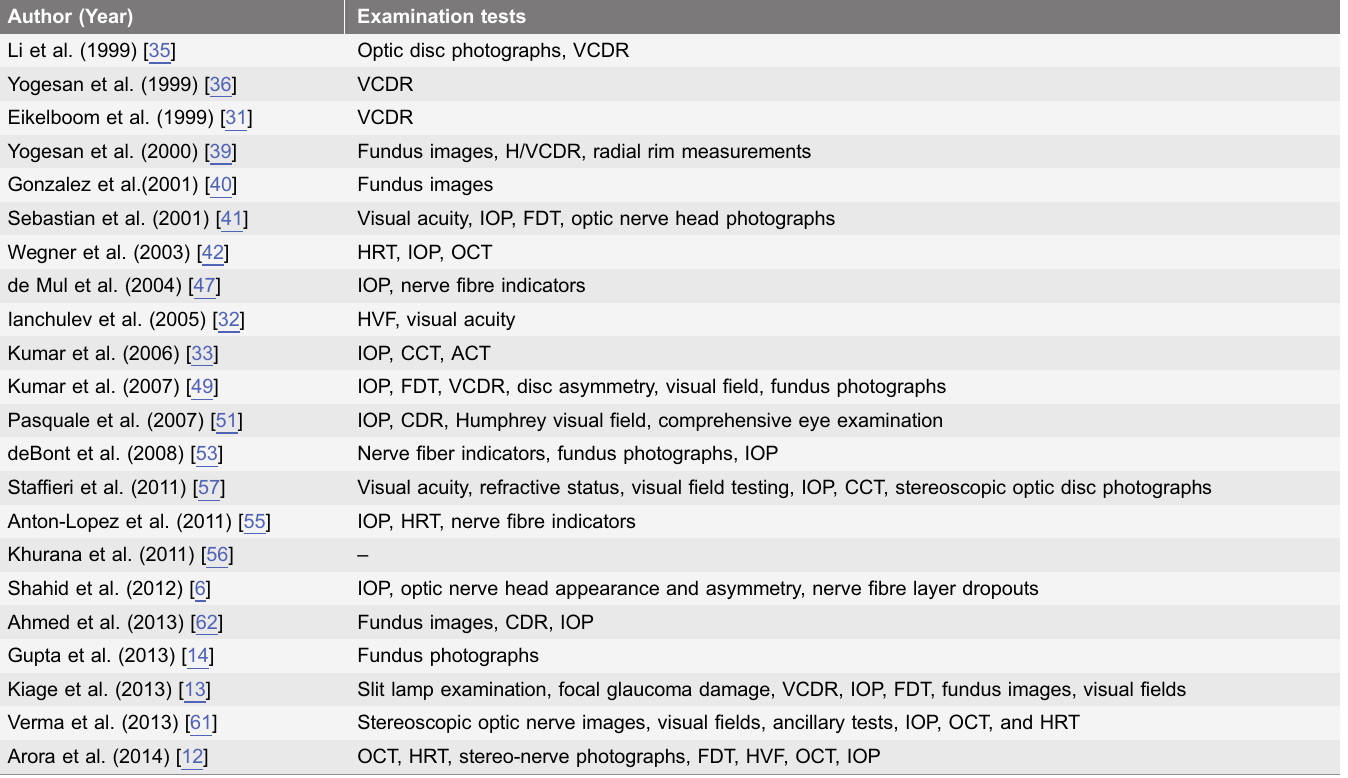
Legend: VCDR 5 vertical cup-to-disc ratio, HCDR 5 horizontal cup-to-disc ratio, IOP 5 intraocular pressure, FDT 5 frequency doubling technology, CCT 5 central corneal thickness, HRT 5 Heidelberg Retinal Tomography, CDR 5 cup-to-disc ratio, HVF 5 Humphrey Visual Field, ACT 5 anterior chamber depth, POAG 5 primary open angle glaucoma, OAG 5 open angle